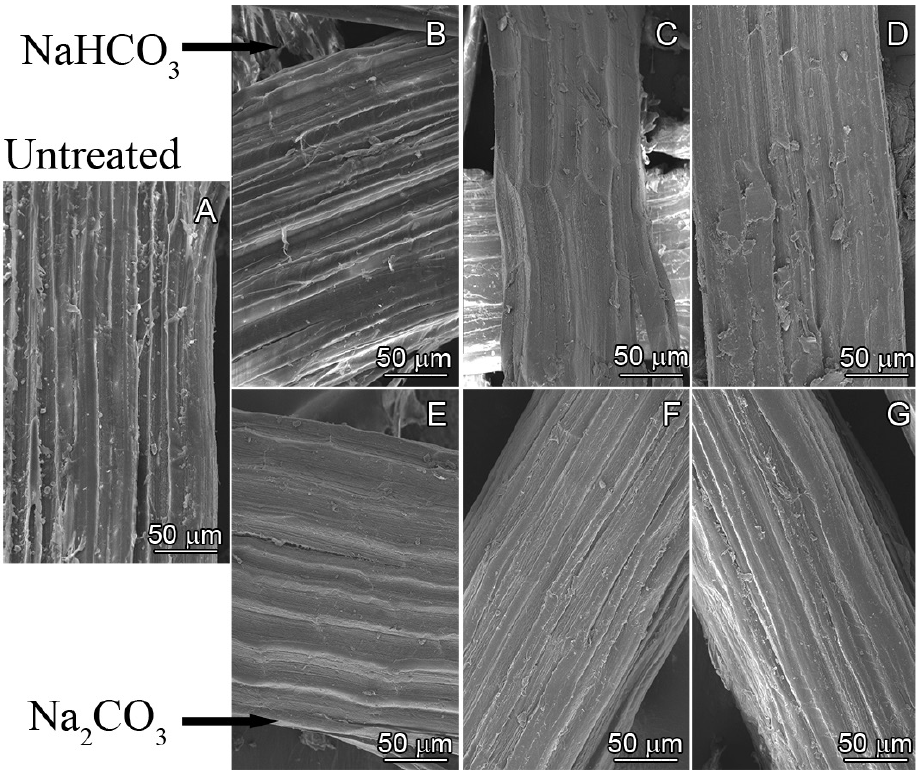
b) 24 h, c) 96 h and d) 168h; treated with Na 3